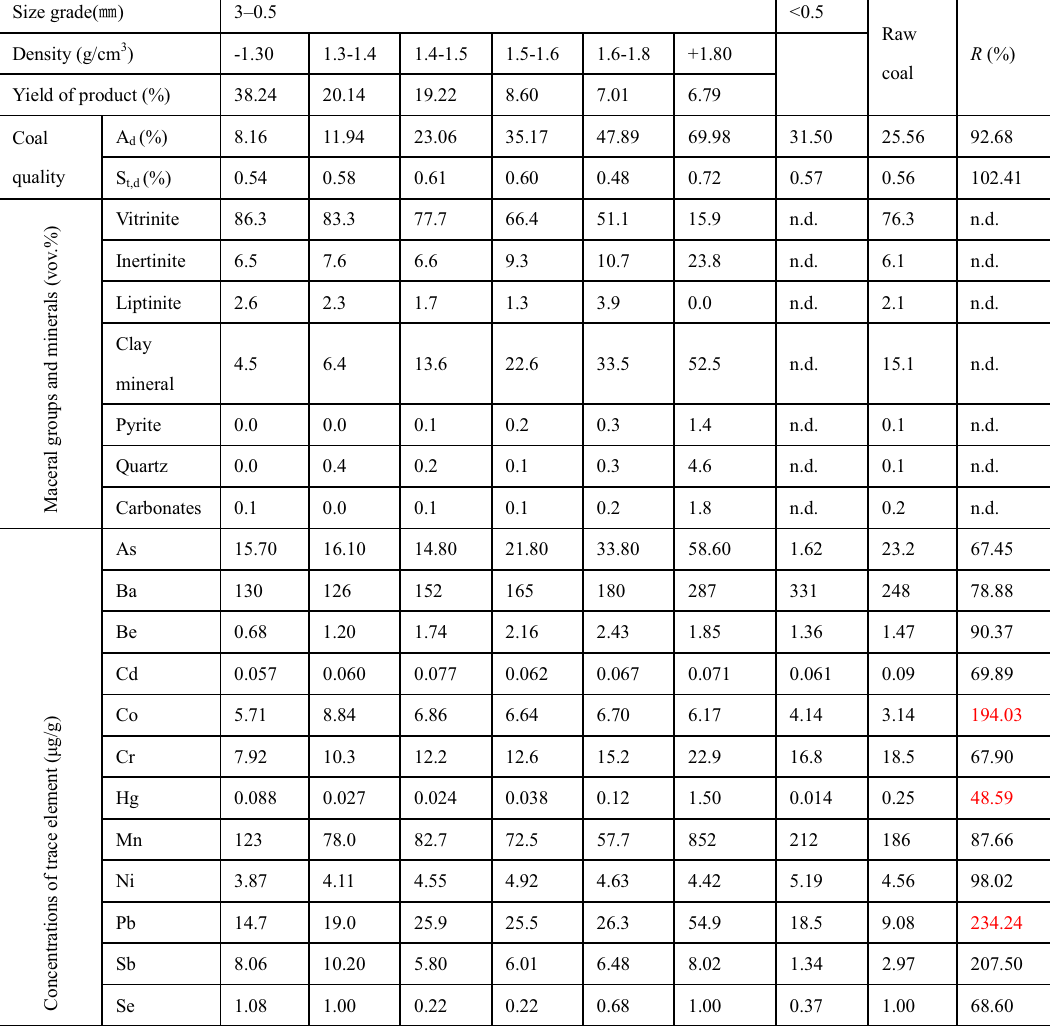
Table 4 Maceral compositions and concentrations of 12 trace elements in the products from the float-sink experiments Size grade( (cid:896) ) 3–0.5